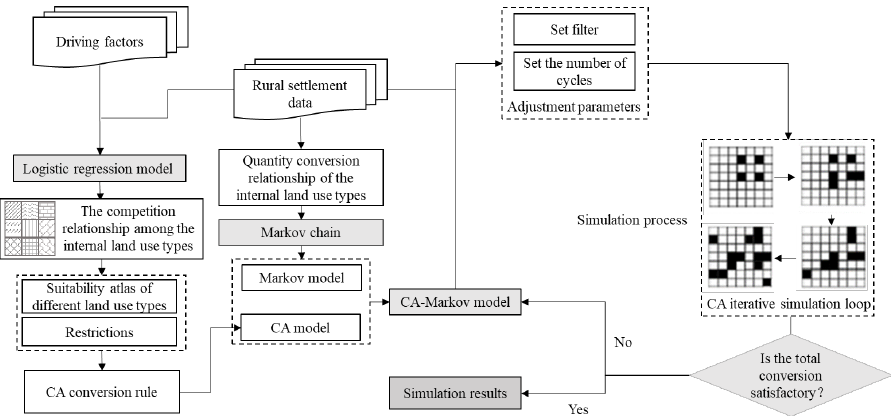
Figure 3. CA – Markov model simulation process. Figure 3. CA–Markov model simulation